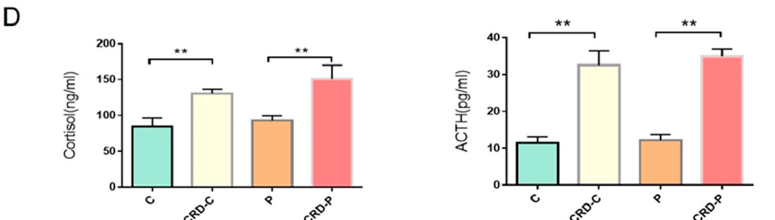
Figure 1. CRD model was constructed in rats. ( A ) CRD model diagram. ( B ) The results of the open field experiment. ( C ) Cross-elevation maze experiment. ( D ) Elisa’s results of cortisol and ACTH. Int. J. Mol. Sci. 2023 , 24 , x FOR PEER REVIEW CRD: circadian rhythm disorders; C: control; CRD-C: CRD without periodontitis. P: periodontitis group. CRD-P: CRD with periodontitis. Data are presented as the mean ± SD. *, p < 0.05; **, p < 0.01.